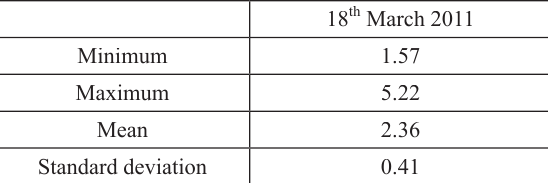
Basic statistics of fl uorescence obtained by sampling in continuous fl